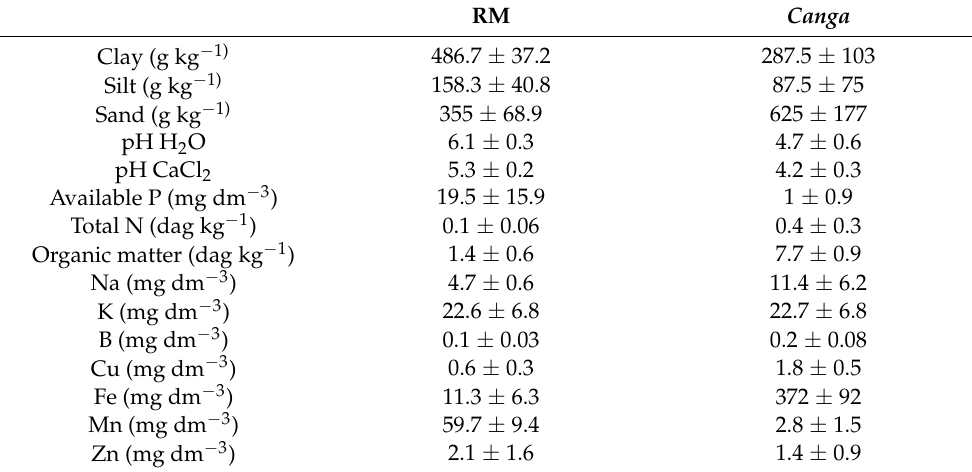
Table 1. Physical and chemical characteristics of soils associated with Dioclea apurensis growing in canga and rehabilitating minelands (RM). Soil results are mean ± standard deviation for n =